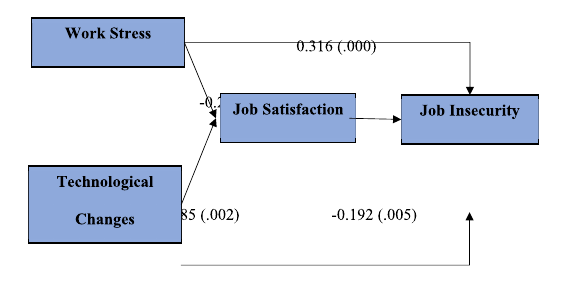
FIGURE4 Estimated model after bootstrapping.